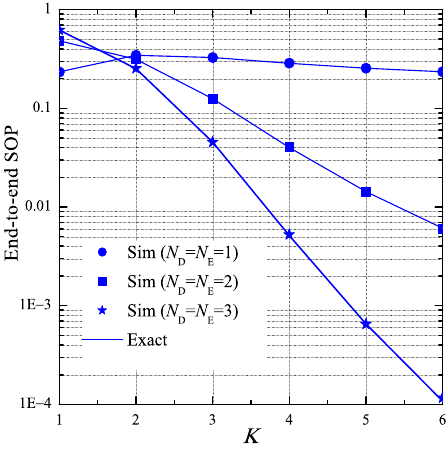
Figure 8. End-to-end secrecy outage probability as a function of K when P S = 0 dB, ε = 0.1, η = 0.1, C th = 0.25, x B = 0.5, y B = 0.3, x P = 0.5, y P = − 0.5, x E = 0.5, y E = 0.5, κ 2